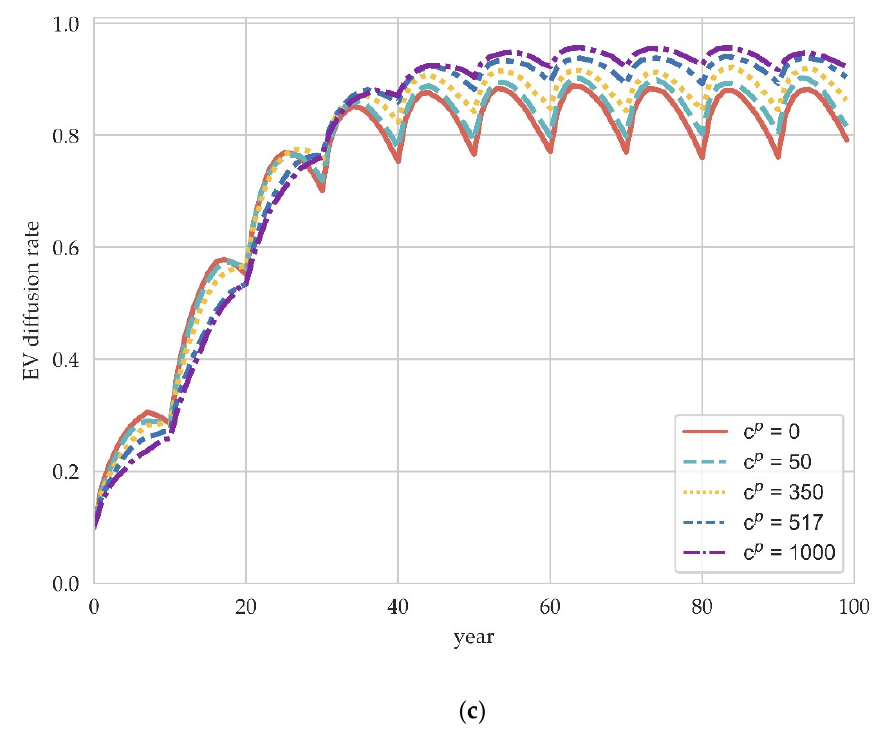
Figure 3. The impact of carbon tax policy on EV diffusion in different scale network. ( a ) 𝑀 = 100 . ( b ) 𝑀 = 200 . ( c ) 𝑀 = 300 .